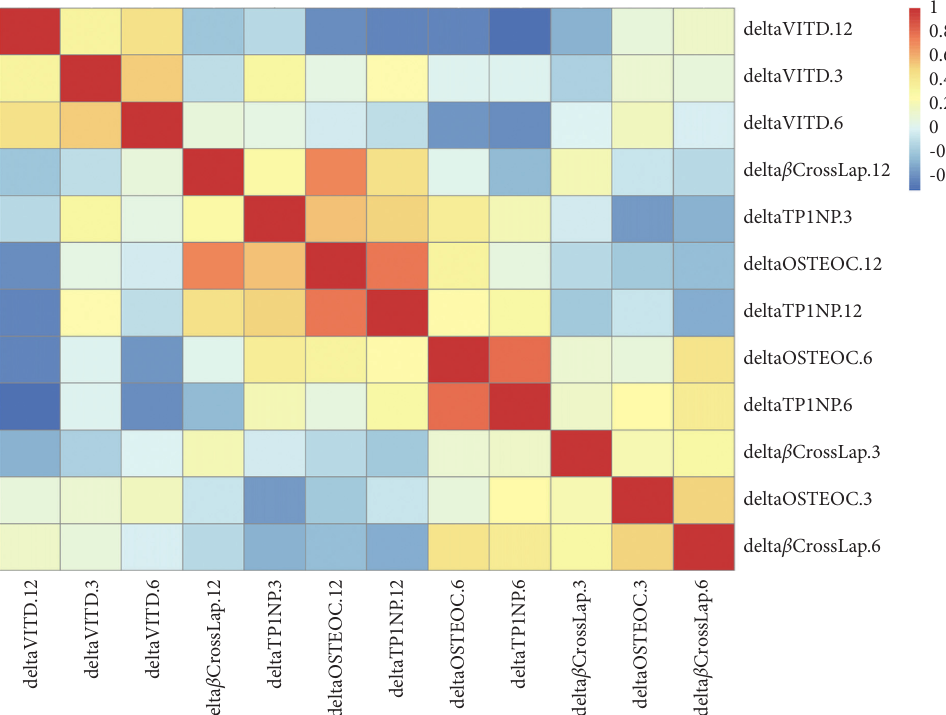
Figure 4: The correlation matrix analysis of 4 bone loss biomarkers. Red means positive relationship and blue means negative relationship. DeltaVITD.3, deltaVITD.6, and deltaVITD.12 mean the delta value tested with VITD assay on point of months 3, 6, and 12. Delta β- Crosslap.3, delta β Crosslap.6, and delta β Crosslap.12 mean the delta value tested with β -CrossLap assay on point of months 3, 6, and